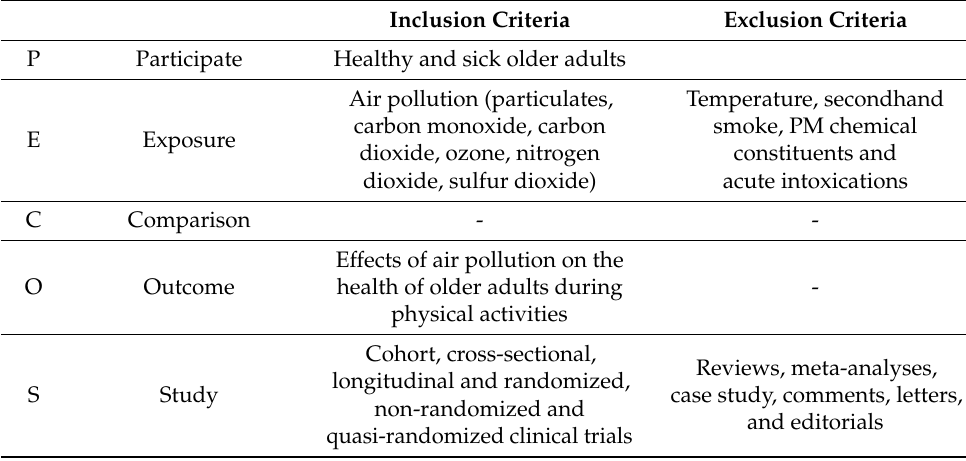
Table 2. Criteria for inclusion and exclusion of studies selected for